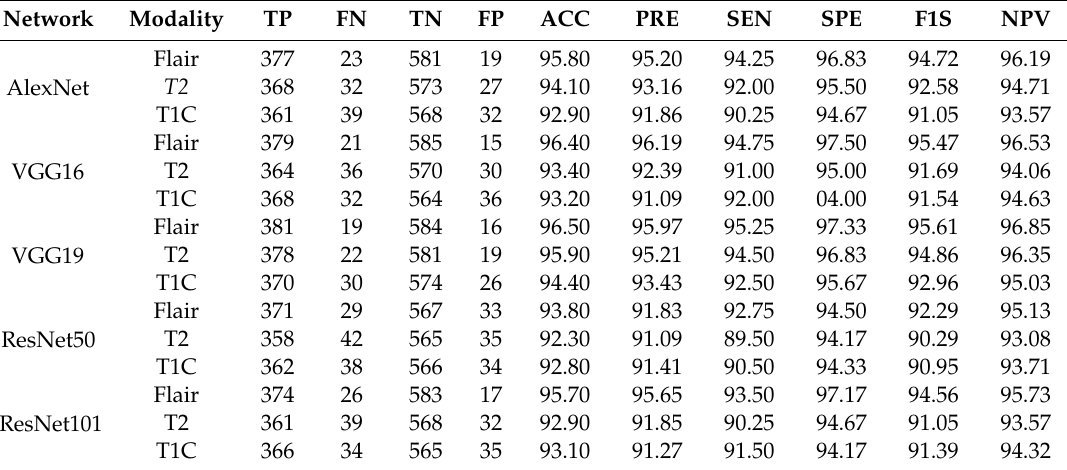
Table 2. Performance measures attained with conventional DLA with SoftMax classifier.